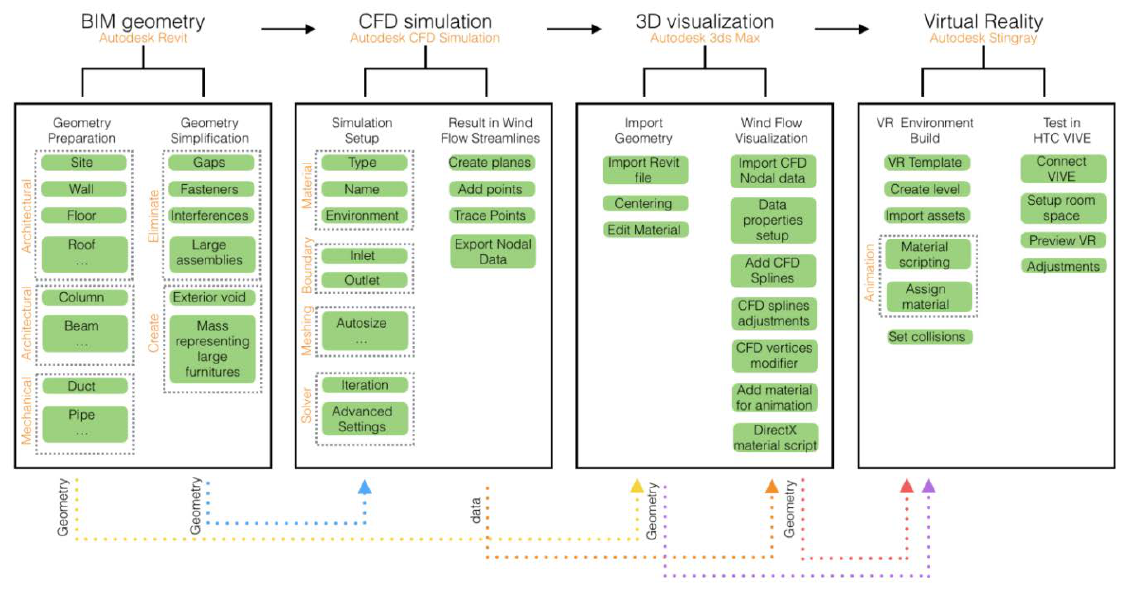
Figure 1. Workflow from building information modeling (BIM) to simulation to virtual reality (VR).